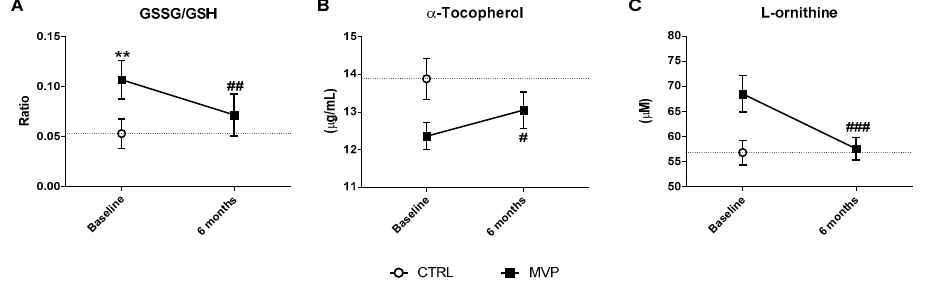
Figure 1. Oxidative stress status evaluation. ( A ) Oxidative stress index (GSSG / GSH) ratio in whole blood, ( B ) α -tocopherol, and ( C ) L-ornithine levels in plasma. All the analyses were performed in mitral valve prolapse (MVP) patients ( n = 45) before (baseline) and 6 months after surgery and in